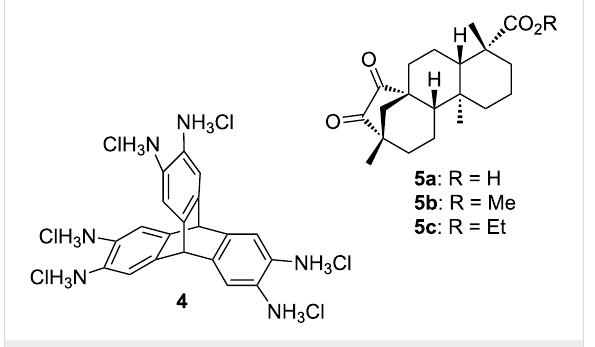
Figure 4: Hexaammoniumtriptycene hexachloride 4 and 15-oxo- derivatives 5a – c of (–)-isosteviol.